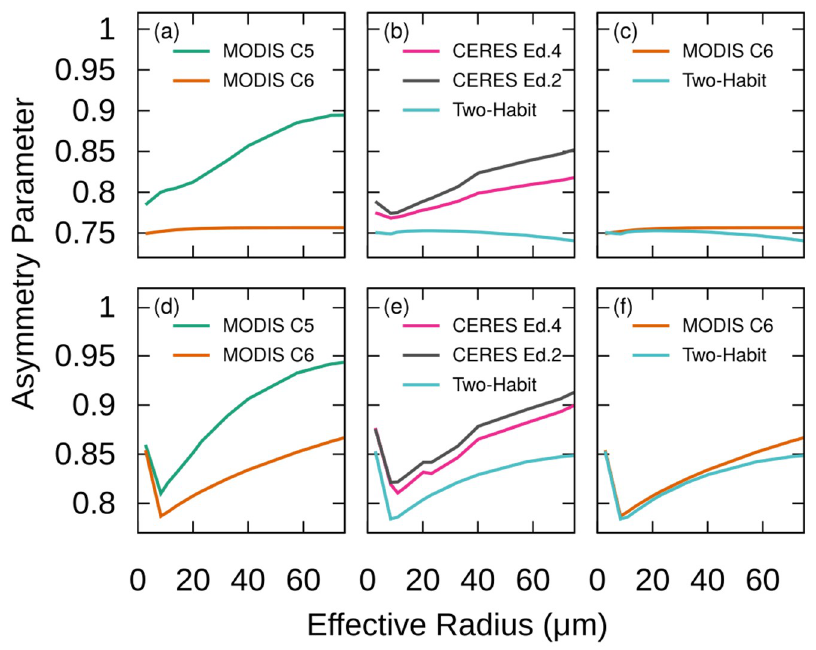
Figure 13. Comparison of the asymmetry parameter at wavelength 0.86 μm based on: ( a ) MODIS Collection 4, 5, and 6; ( b ) CERES Edition 2 and 4, and the two-habit model; and ( c ) MODIS Collection 6 and the two-habit model. ( d – f ) Counterpart of ( a – c ) at wavelength 2.13 μm.